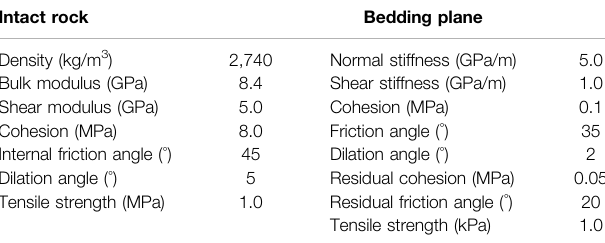
TABLE 3 | Input parameters for the excavation